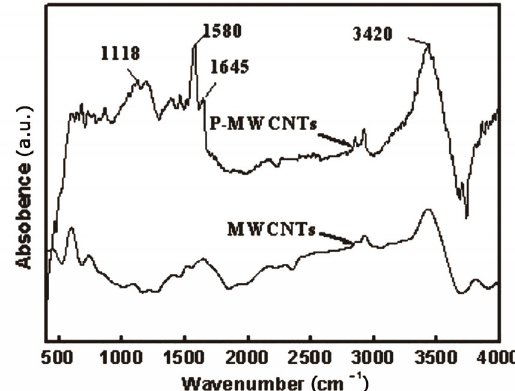
Fig. 2 FTIR spectra of the pristine and plasma-treated